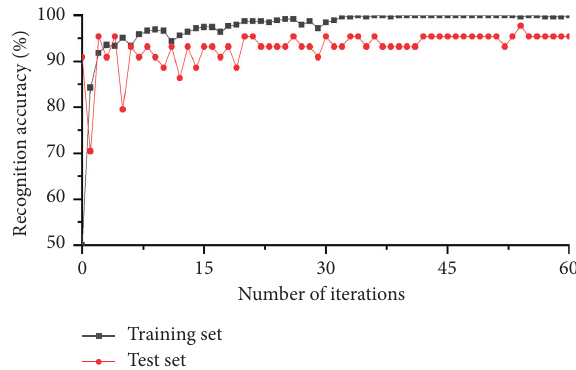
Figure 16: Change curves of sample recognition accuracy rate during model